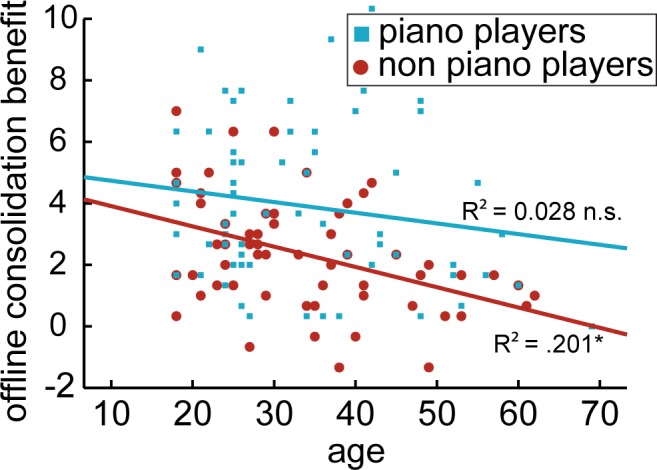
Age-related decrease in memory consolidation.The non-piano group shows a significant decrease in memory consolidation with increasing age (r = -.448, p =. .0002). For the piano players this effect is not significant (r = -.167, p = .187) and weaker as compared to non-piano players (z = -1.73, p = 0.042, one-tailed). This pattern of results indicates that piano experience has a protective effect preventing the usual age-related decline in procedural consolidation. The asterisk denotes a significant difference (p < .05).